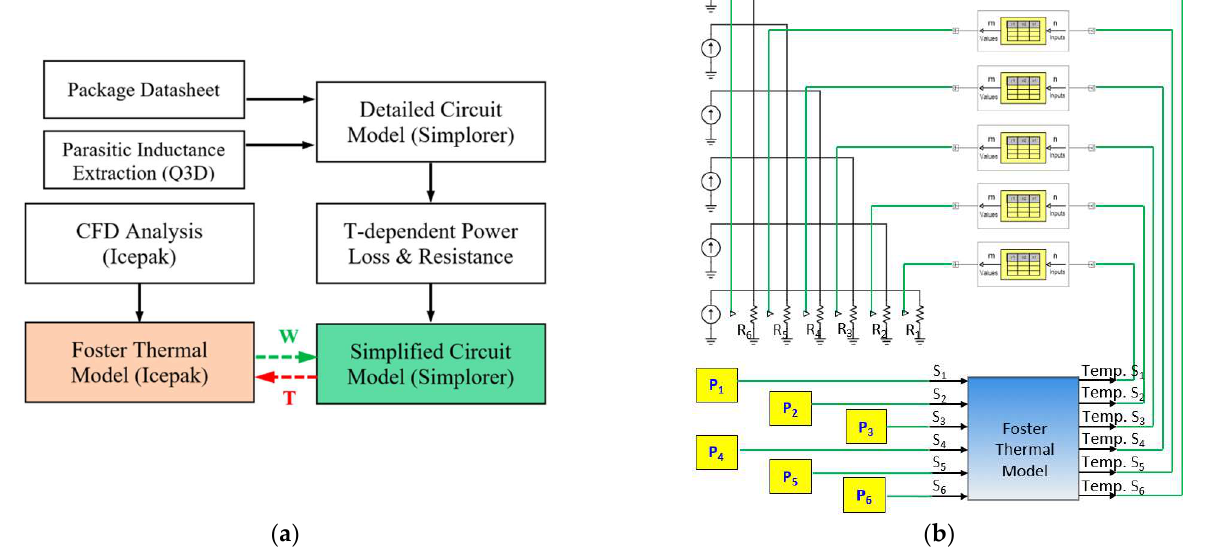
Figure 7. ( a ) Analysis flow of the proposed ETCA model and ( b ) simplified equivalent circuit model.